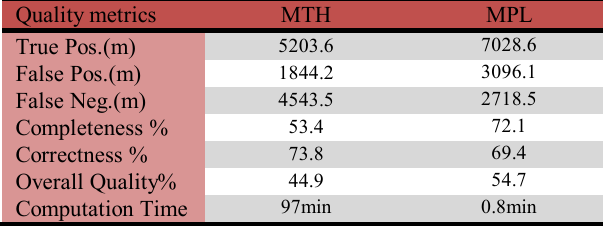
Table 1. A comparison of the proposed method (MPL) and